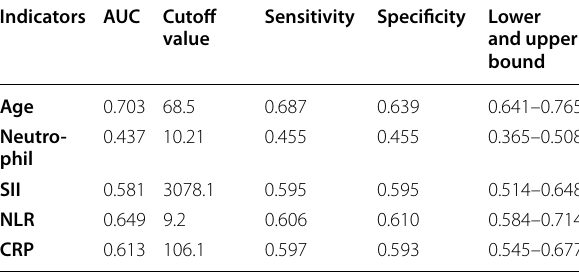
Table 4 The AUCROC of each independent risk or prediction factors Indicators AUC Cutoff